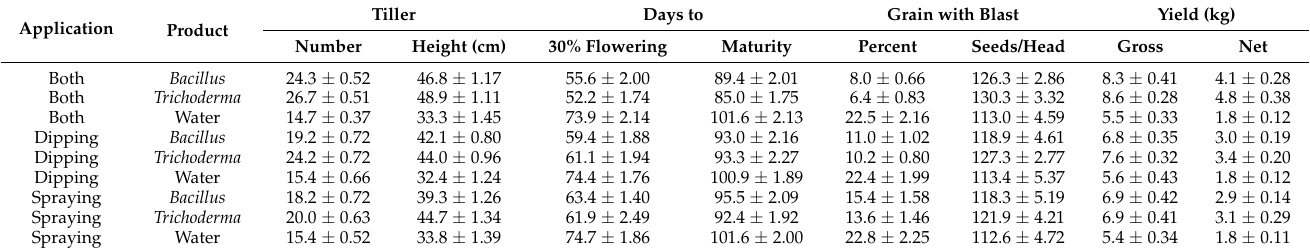
Table 3. Treatment means and standard errors; rice plants were treated with formulated B. subtilis and T. asperellum strains in addition to water (as a control) in three different ways to manage rice blast. The experiment was carried out at three sites in Tanzania in 2020 and 2021; each mean is an average of 18 independent replicates.